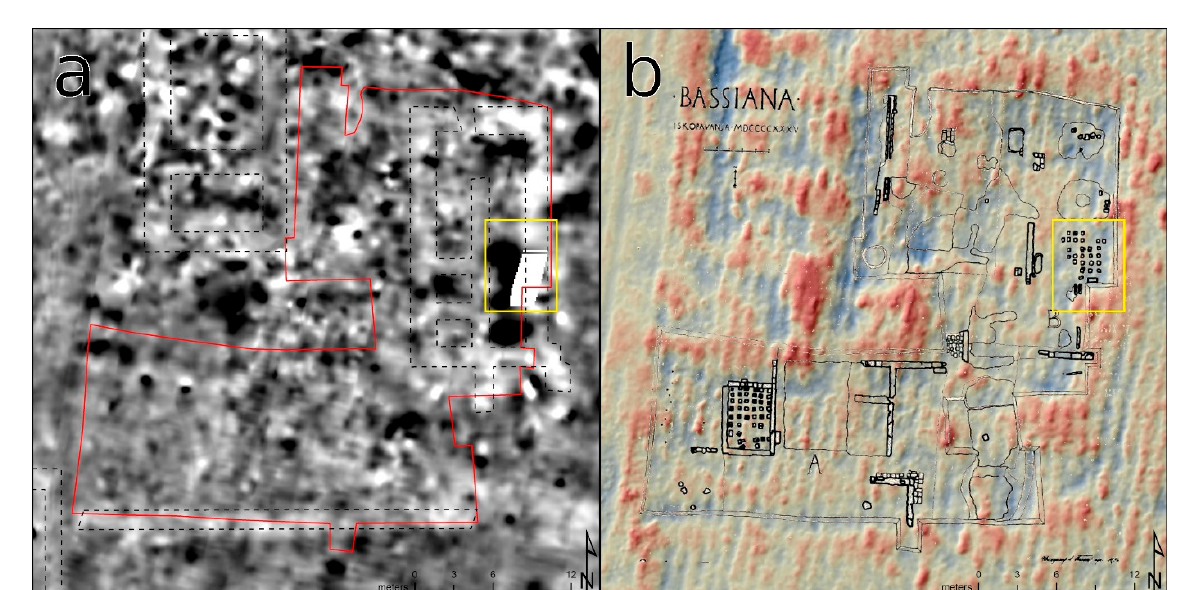
Figure 16. Comparison between the magnetic data ( a ) and the excavation results from 1935 ( b ) superimposed on a simple local relief model fused with a hillshade. The excavated area is visible in the topography and partly can be recognized in the magnetic data (red line). While the excavation has left an imprint on the magnetic data, there still exists some agreement between excavated structures and magnetic anomalies (e.g., yellow box). The magnetic data interpretation shown in ( a ) as dotted lines was done prior to and independently of the comparison with the excavation results. Drawing: [6] (p. 2).